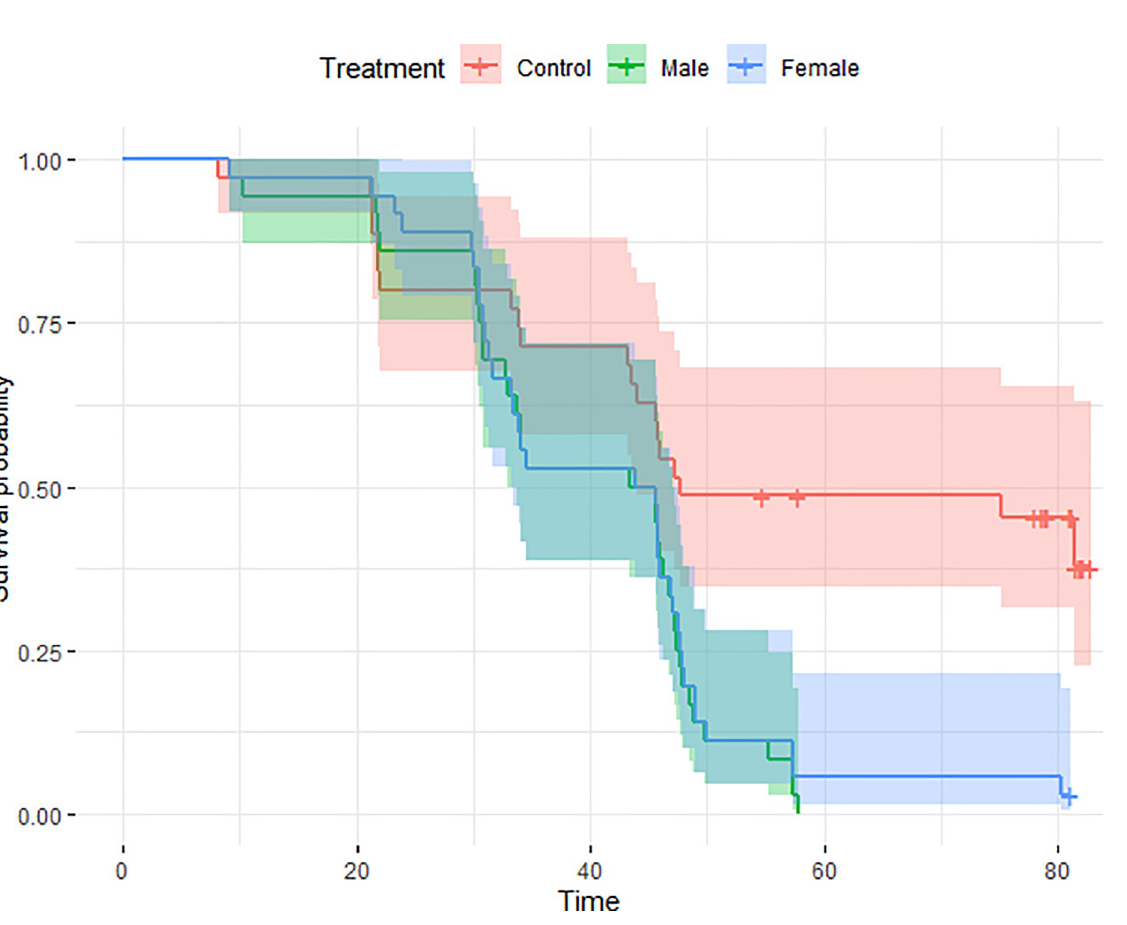
Fig 2. Nest survival in relation to presence of male decoy (N = 36), 95% CI (33.2–47.0), female decoy (N = 36), 95% CI (33.0–47.0) and control (N = 35), 95% CI (44.0—NA). Total number of nests: N = 107.